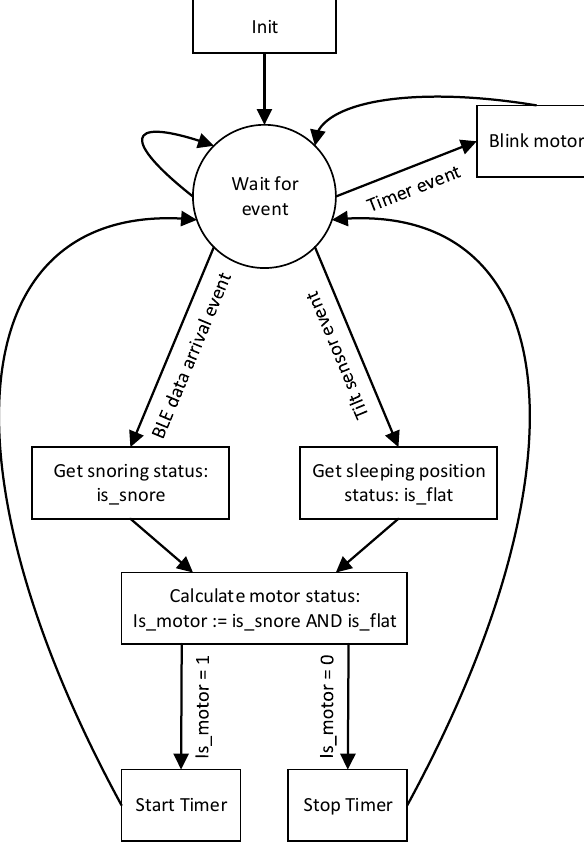
Figure 7. Flowchart of the wearable gadget firmware.